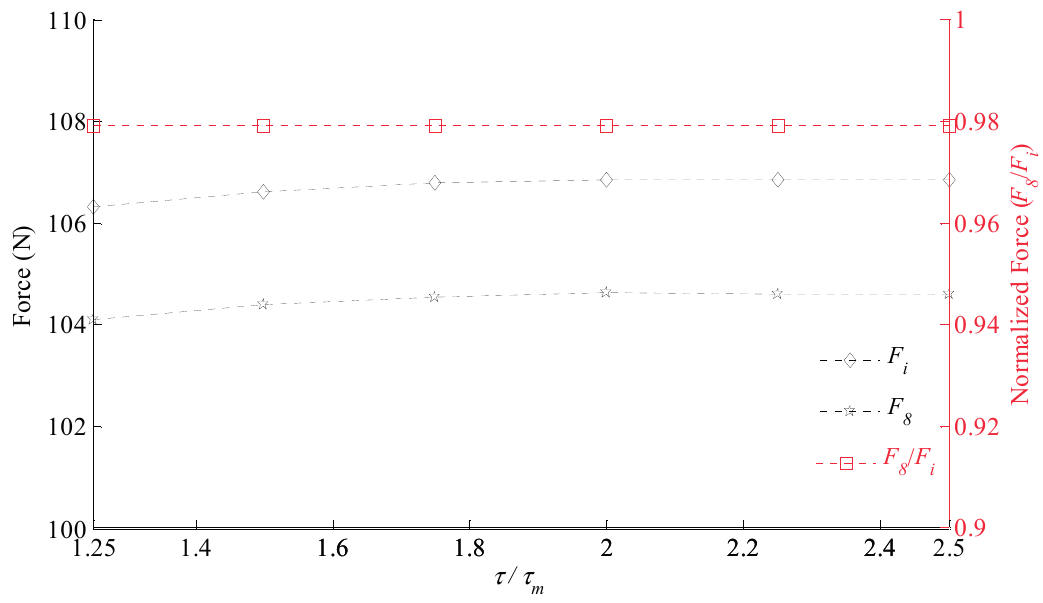
Figure 13. Normalized force ( = F ) and for an actuator with eight segments with parallel magnetization ( F magnetization ( F i as function of the ratio between permanent magnet length in the axial direction τ pole pitch in the axial direction τ